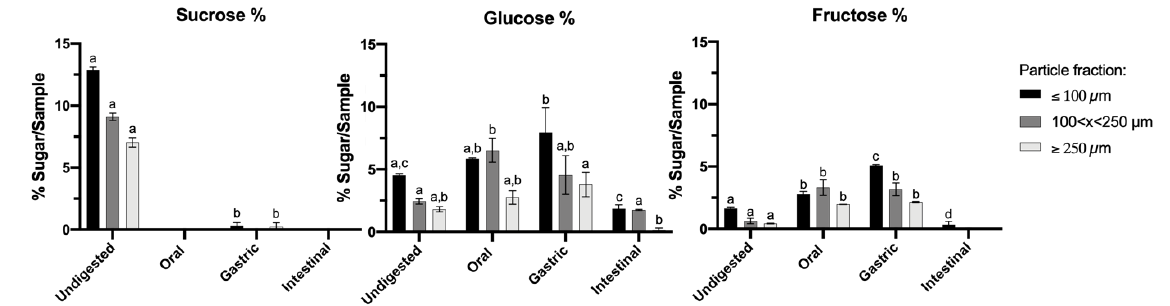
Figure 2. Sucrose, glucose and fructose content in different particle fractions of CF throughout GIT simulation. The bars represent the standard deviation; for a given fraction, results with different letters differ significantly throughout GIT digestion.